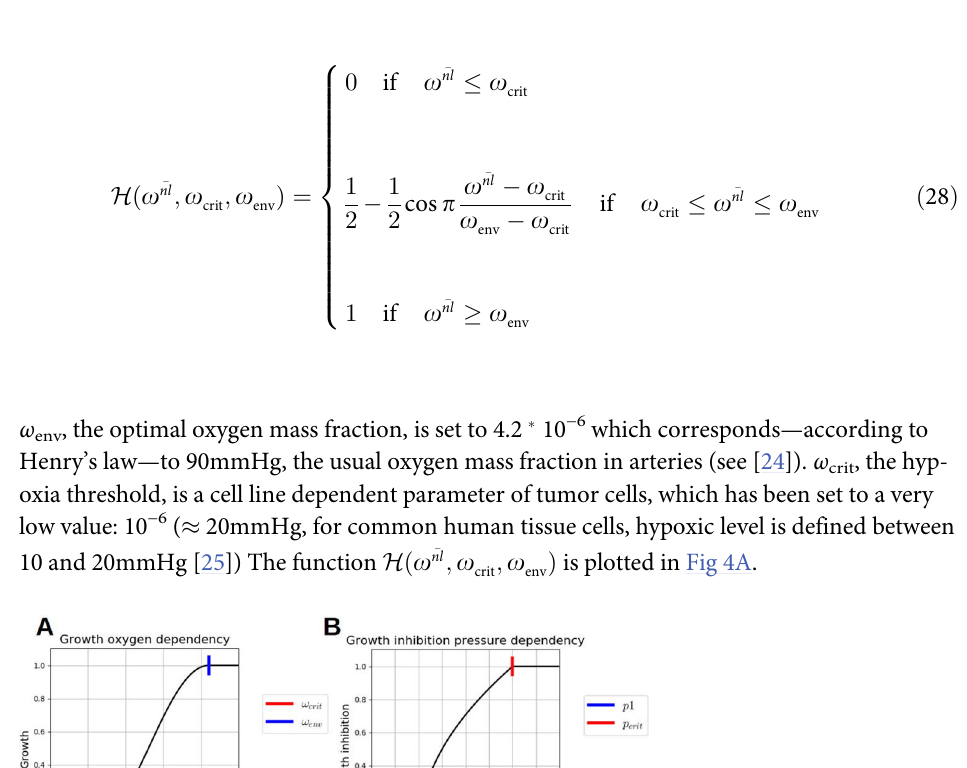
Fig 4. Two mechano-biological laws. A H ð o � nl ; o